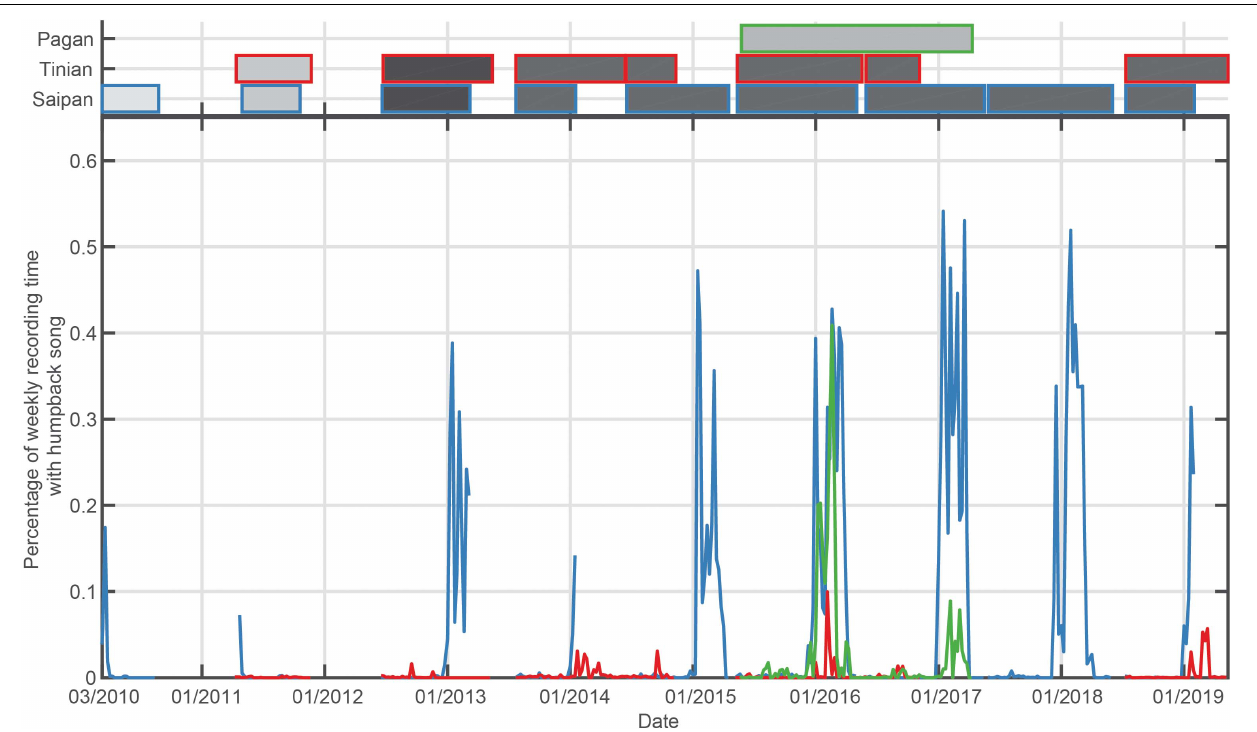
FIGURE 4 | Bottom panel: Percentage of recording time with humpback song per week for the Mariana Islands. Top panel: Shaded boxes represent the time periods that have recordings, with outer color corresponding to the recording site, and shading indicating duty cycle that ranged from 12.5% recording time (light gray) to continuous